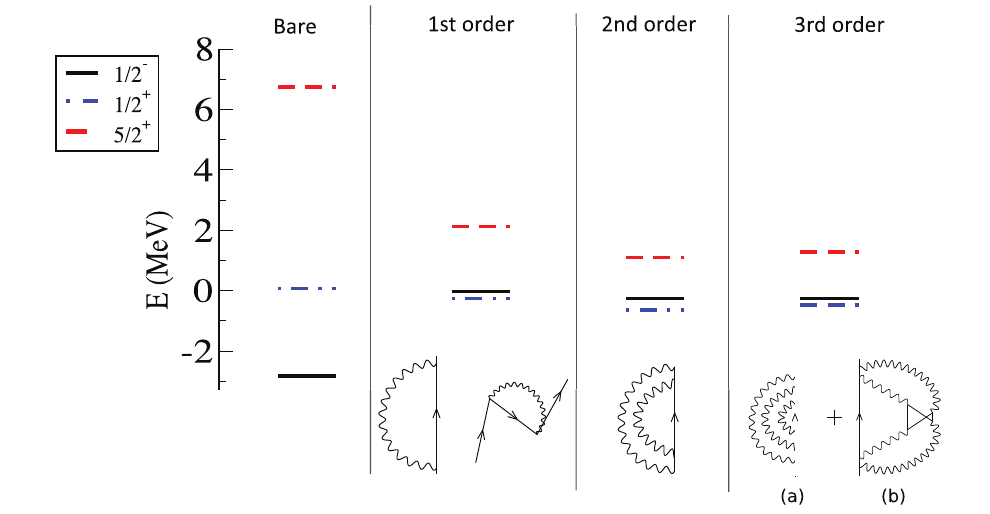
Figure 1. (color online) Theoretical spectrum of low-lying states of 11 Be, calculated in di ff erent perturbation orders in NFT. The lowest 1 / 2 − ,1 / 2 + and 5 / 2 + levels are shown by solid, dot-dashed and dashed lines respectively. In the case of 5 / 2 + , the energy of the resonant state is indicated. Representative diagrams included at each order are drawn at the bottom of the figure.